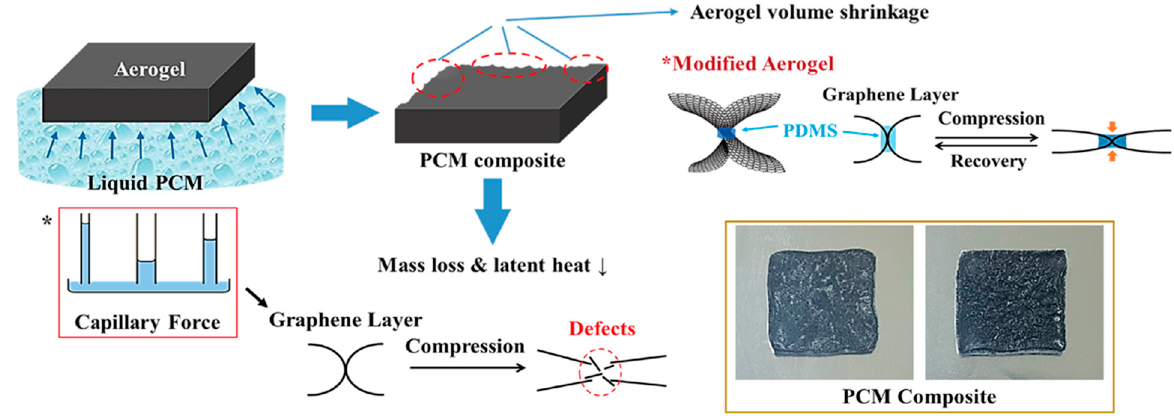
Figure 7. Schematic demonstration of the volume shrinkage of graphene aerogel.